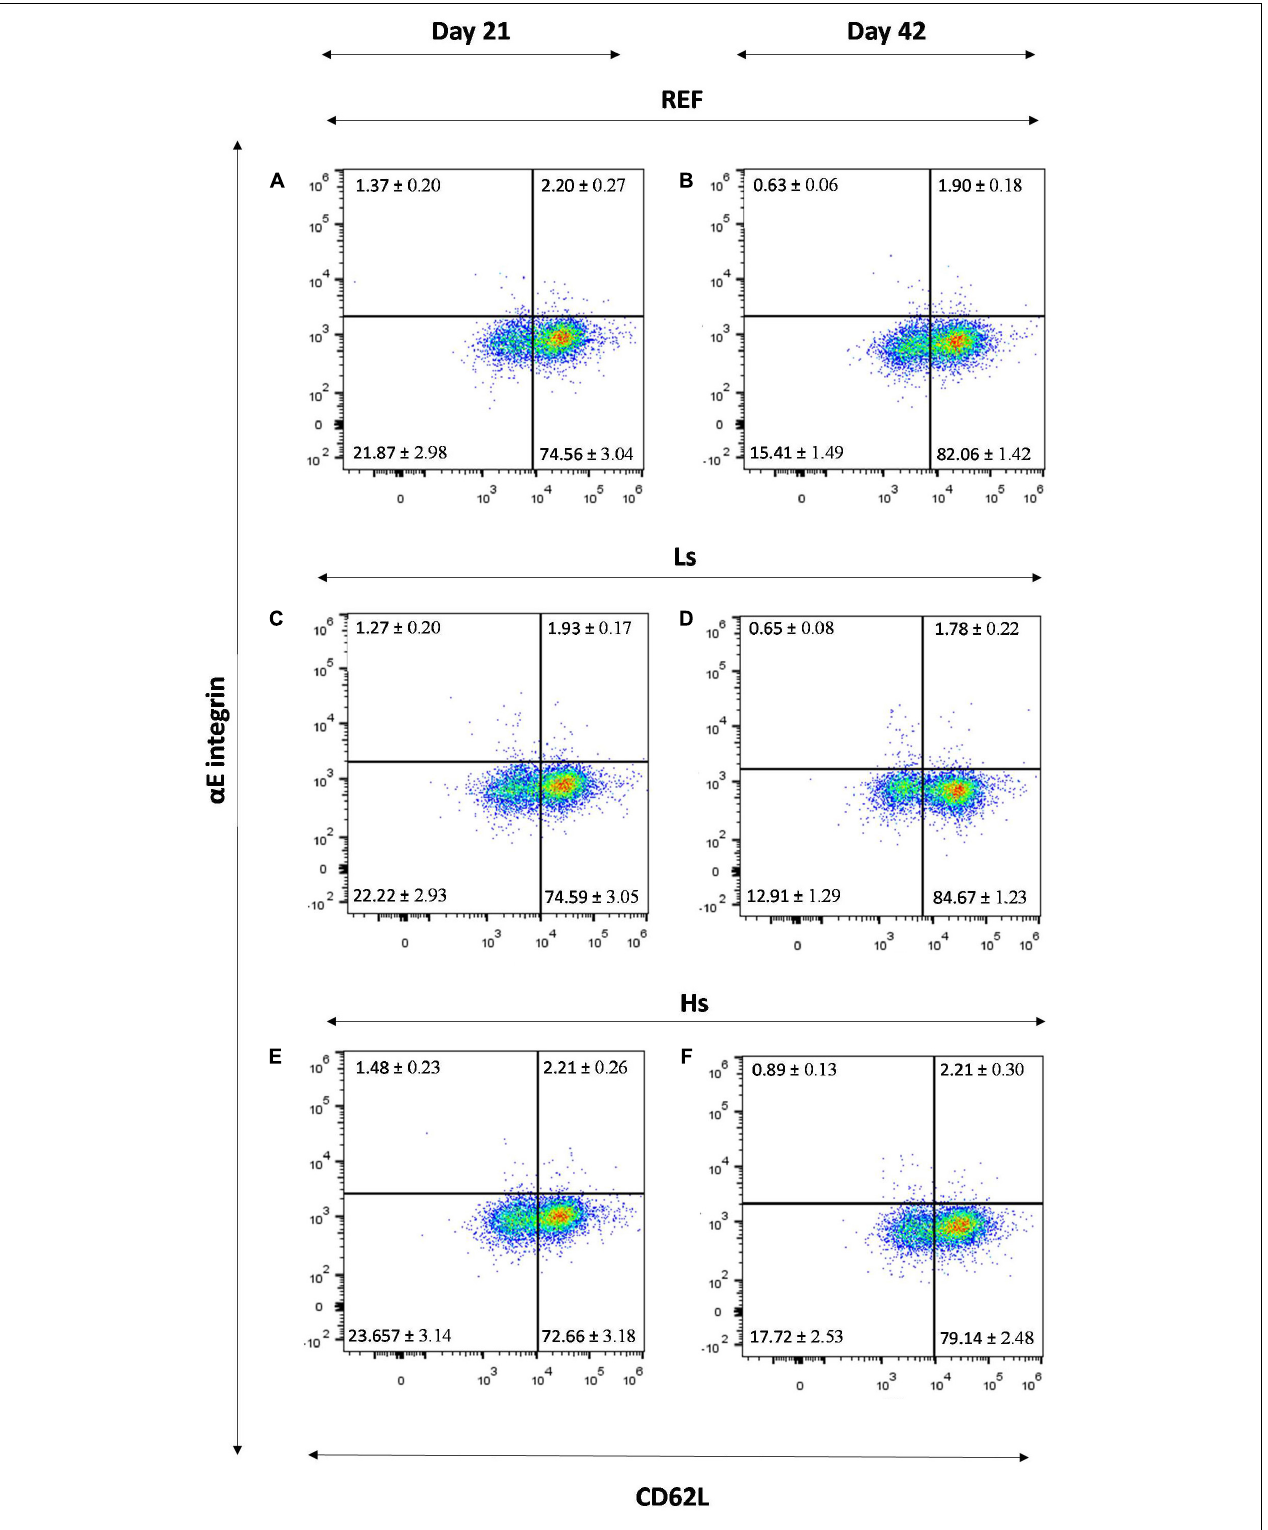
FIGURE 4 | α E integrin/CD62L molecular pattern in the total lymphocytes of the spleen of REF (A) , Ls (C) , Hs (E) animals at day 21 and REF (B) , Ls (D) , Hs (F) animals at day 42. Representative histograms for each group. Results are expressed as mean ± S.E.M ( n = 12 animals/group). REF, reference group; Ls, group supplemented with low dose of S. epidermidis and Hs, group supplemented with high dose of S. epidermidis .